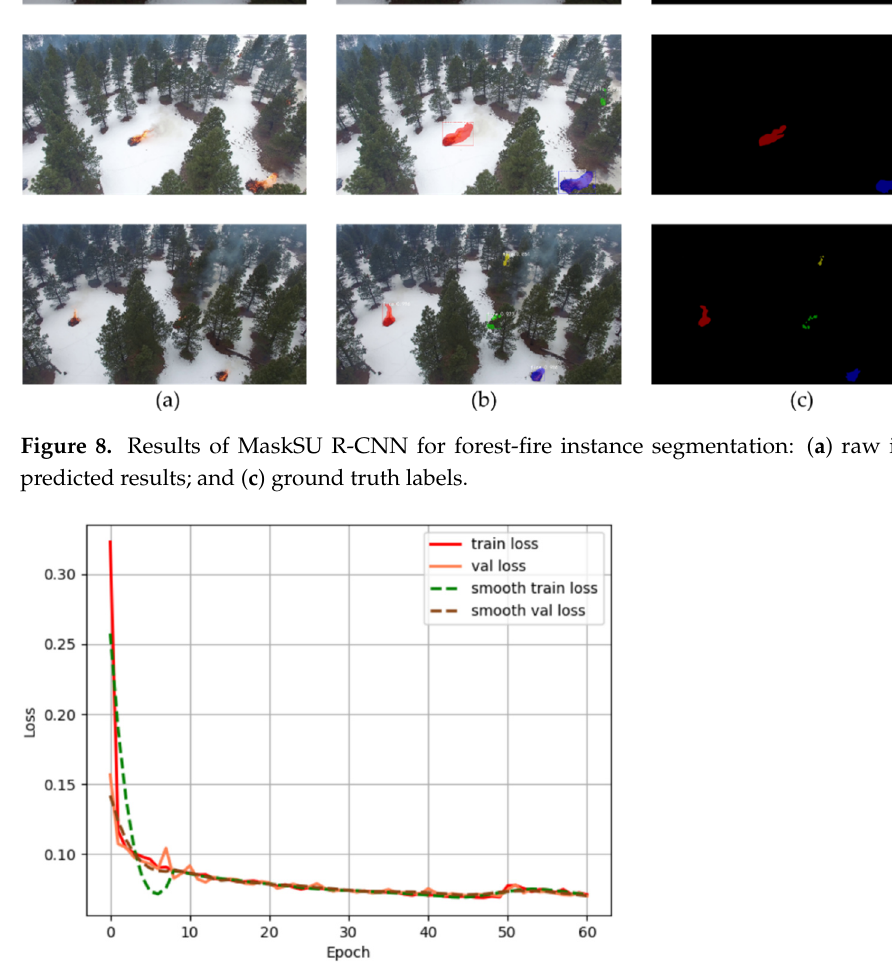
Figure 9. Loss curves of MaskSU R-CNN.